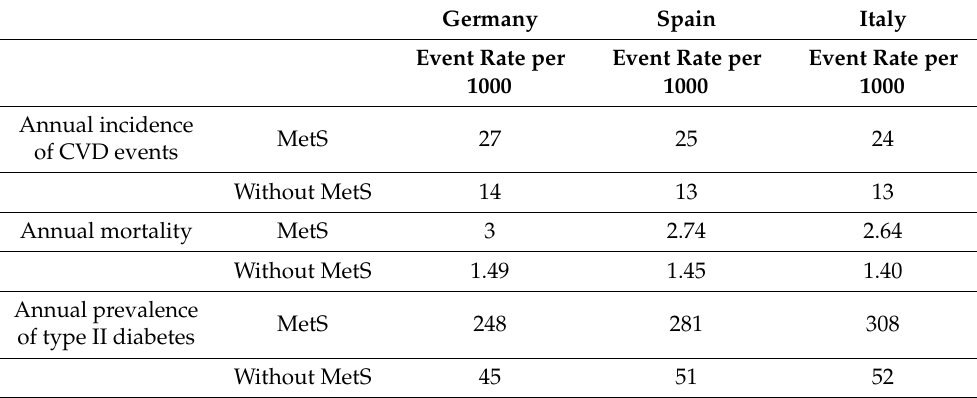
Table 2. Annual number and event rate per 1000 hypertensive patients of incident CVD cases, incident mortality and prevalent cases of diabetes type II (table content elaborated and modified from the original article by Scholze et al., 2010 [26]).